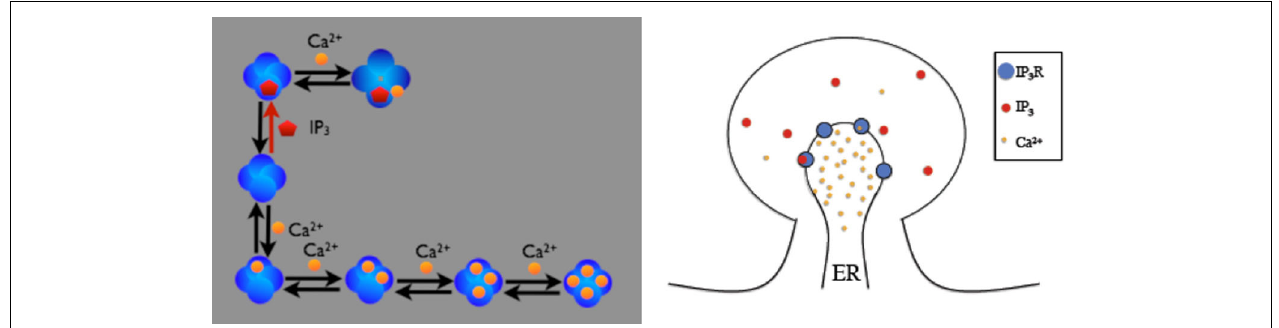
FIGURE 3 | Schematic description of the IP 3 R model on a spine. IP 3 receptors on the membrane can be opened by firstly binding with cytosolic IP 3 then Ca 2 + , or can be inactivated by binding Ca 2 +